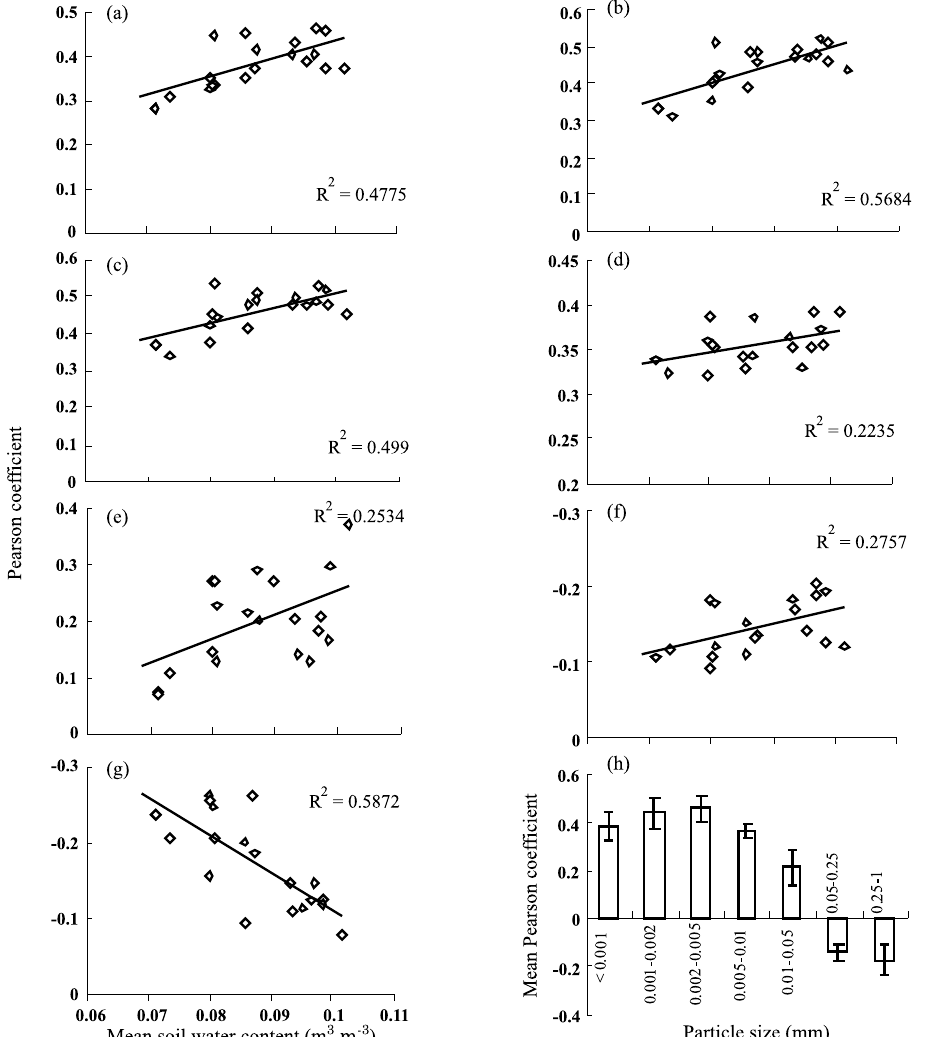
Figure 5. The linear fitting between mean soil water content and Pearson coefficient for particle sizes in the filled deposited farmland soil; (a) <0.001mm; (b) 0.001-0.002 mm; (c) 0.002–0.005; (d) 0.005–0.01 mm; (e) 0.01-0.05 mm; (f) 0.05–25 mm; (g) 0.25–1 mm; (h) the mean values of Pearson